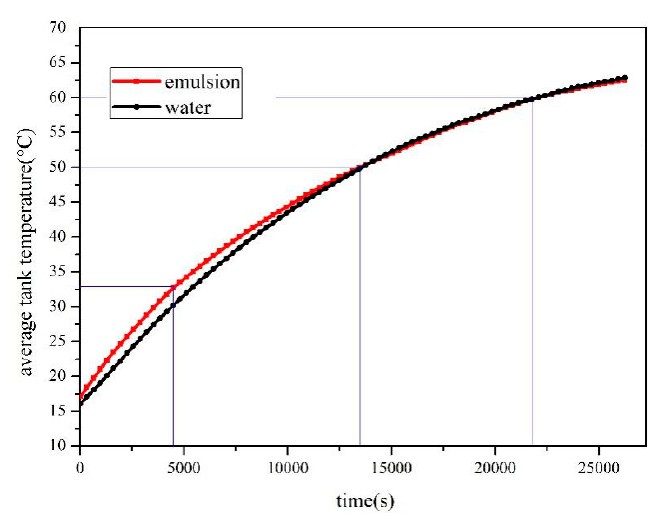
Figure 8. The average temperature curve of the tank.